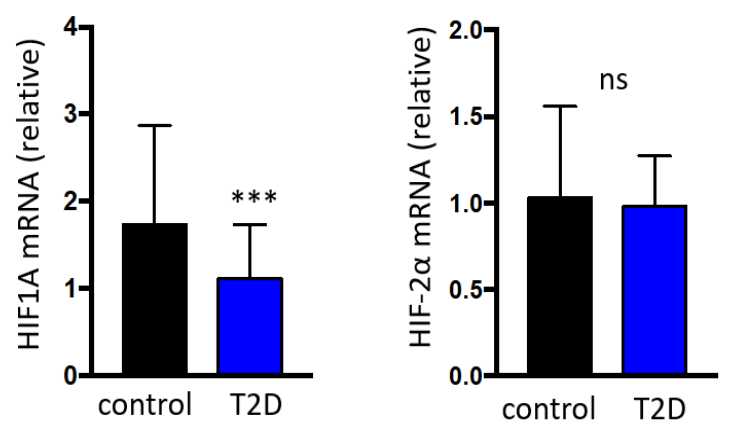
Figure 1. Relative HIF-1α and HIF-2α gene expression based on the presence of type 2 diabetes. Data are presented as median and interquartile. *** p < 0.001; ns = non-significant. HIF: Hypoxia-Inducible Factor; T2D: type 2 diabetes; mRNA: messenger ribonucleic acid.